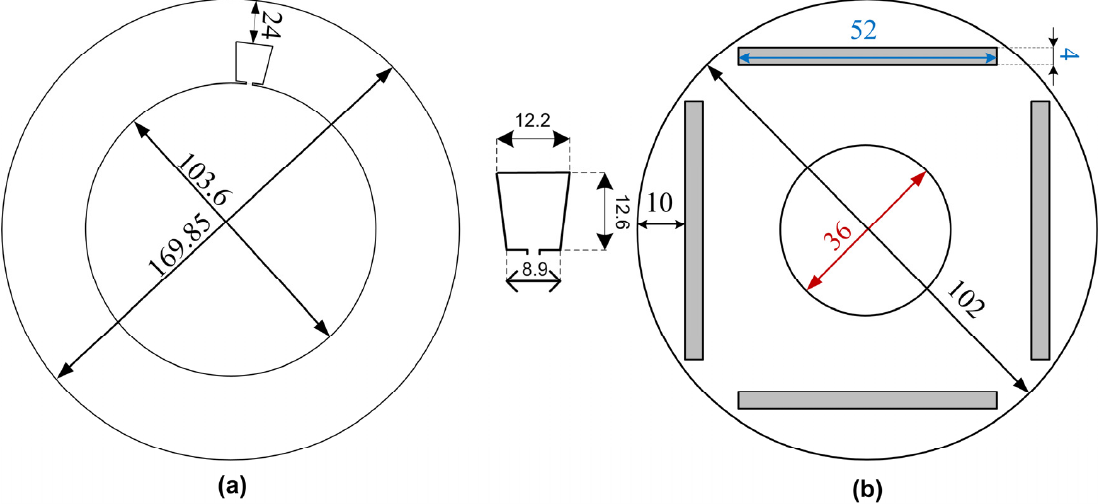
Figure 1. The initial geometric dimensions: ( a ) stator, ( b ) rotor .